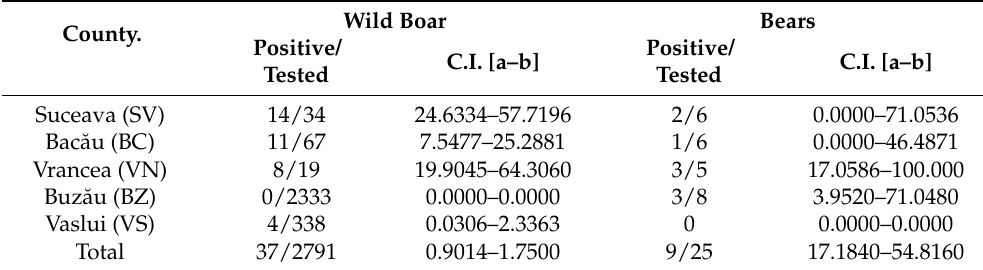
Table 4. Geographical prevalence of T. britovi in wild boar and bears in North-Eastern Romania.